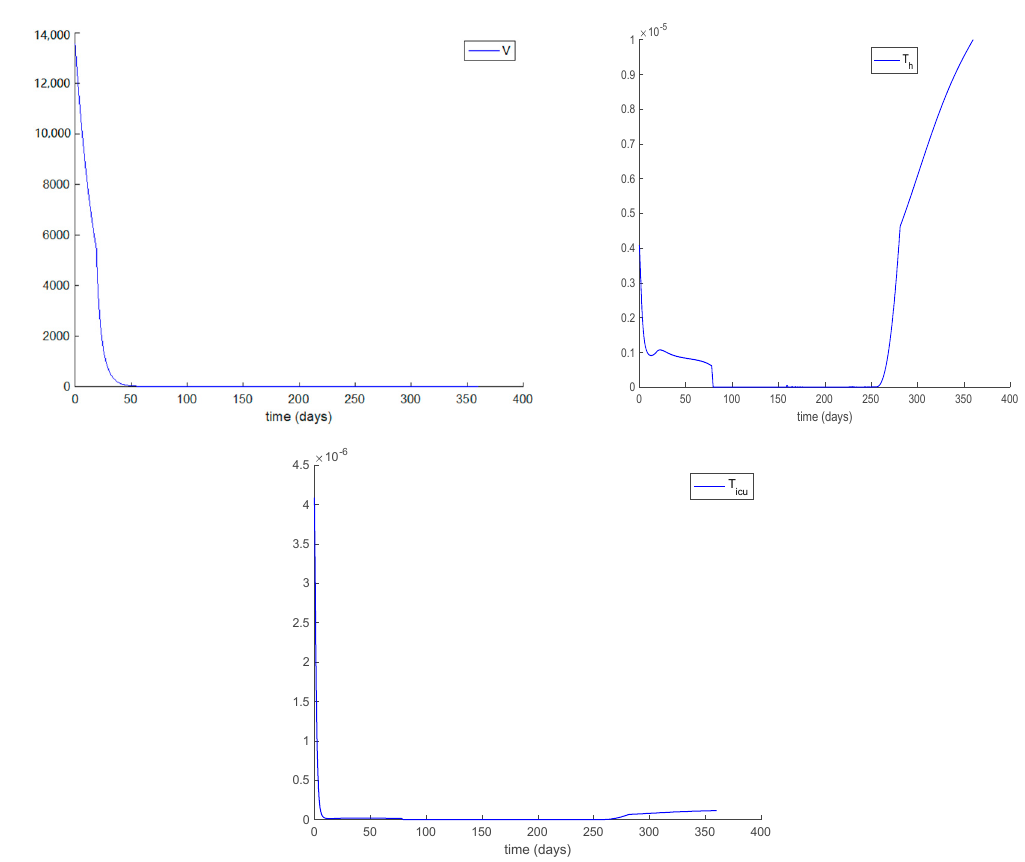
Figure 13. Control actions when Programme 6 is employed.